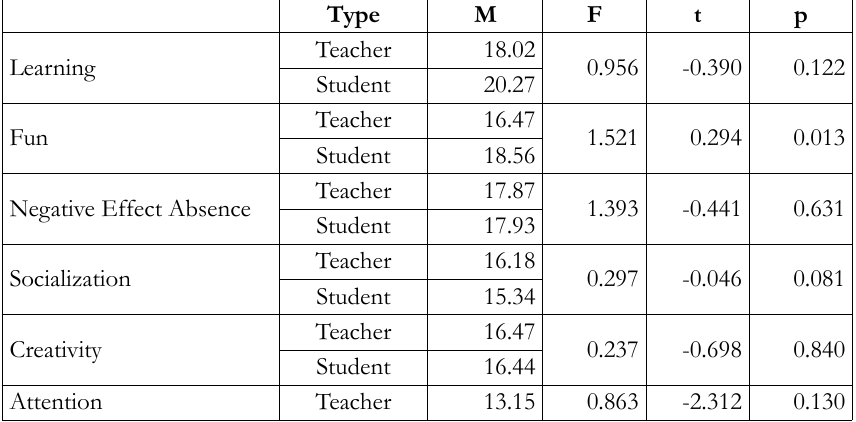
Table 5. Student’s t test results according to the type of